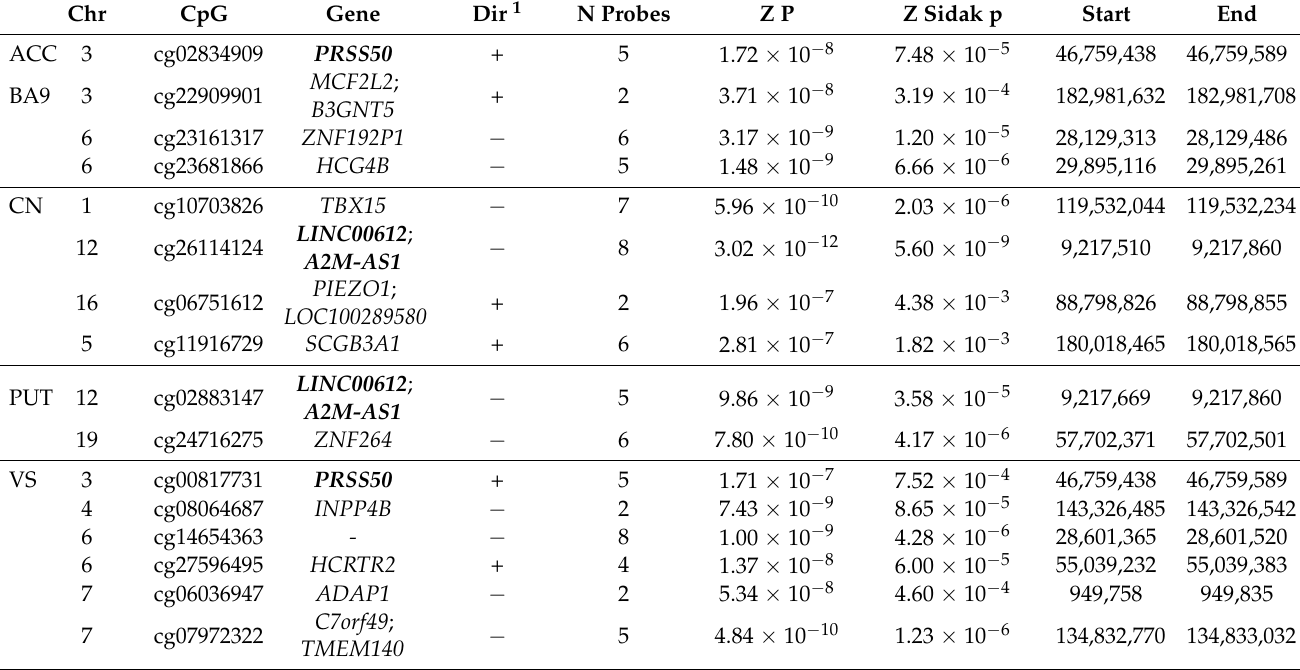
Table 2. Differentially methylated regions (DMRs) identified in the five brain